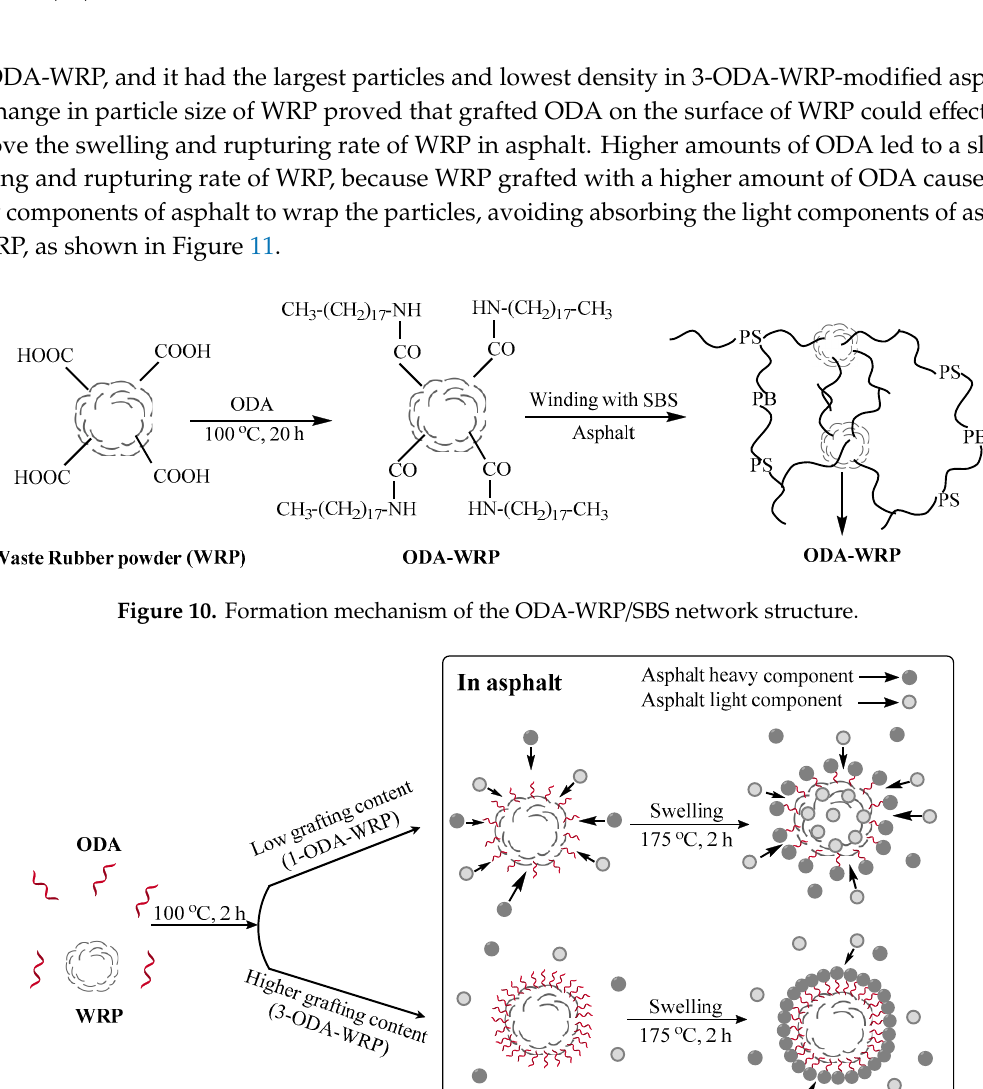
Figure 11. Swelling mechanism of different types of WRP. 382